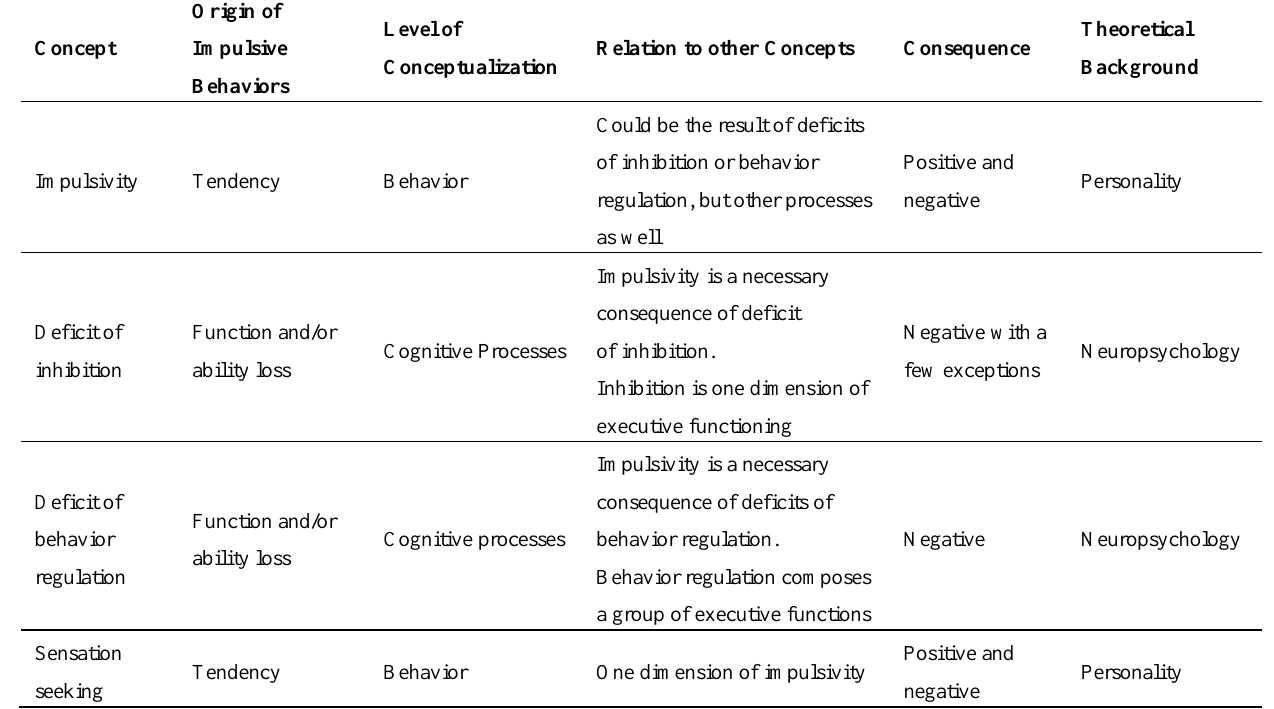
Table 2. Similarities and distinctions between general concepts related to post-TBI